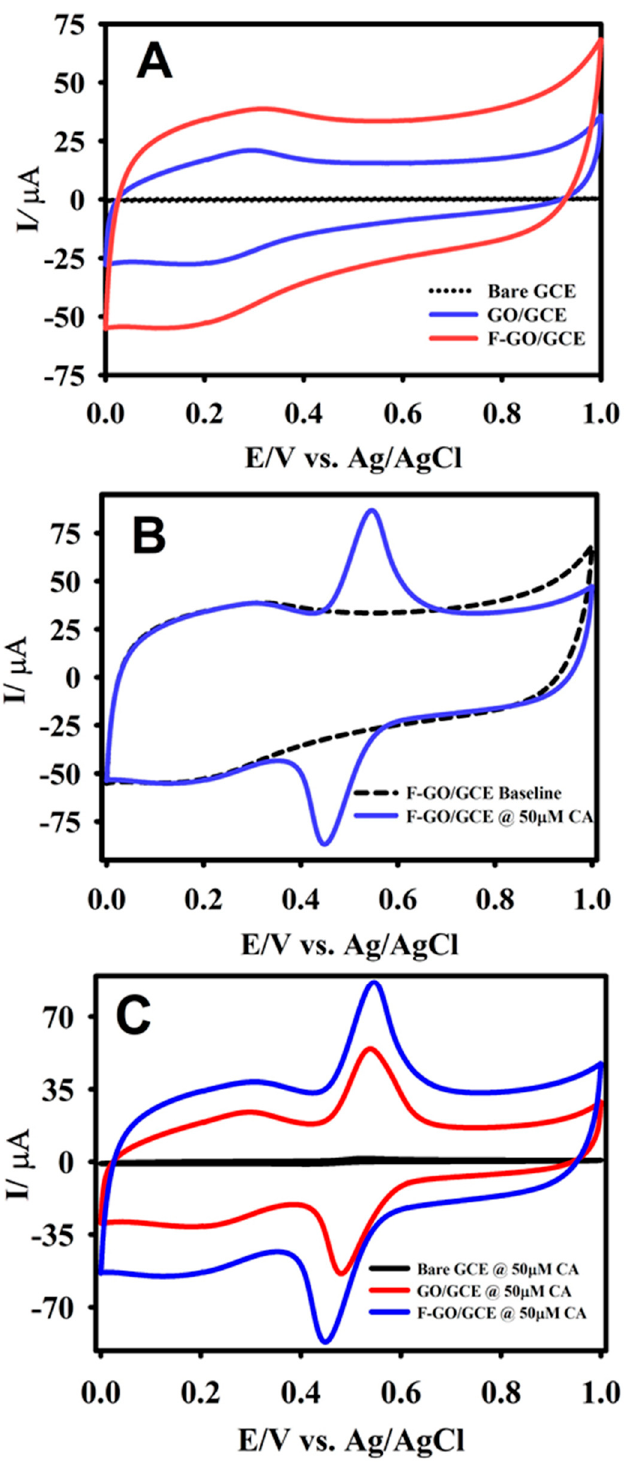
Figure 4. The CV curves of bare GCE (dashed black line), GO/GCE (blue line), and F-GO/GCE (red line) recorded in the absence of caffeic acid (CA) ( A ); the F-GO/GCE response in the presence of 50.0 µ M CA ( B ); a comparison of the modified GCEs in the presence of 50.0 µ M CA ( C ) in a 0.1 M B-R buffer solution (pH 2.65) at a scan rate of 50 mV s − 1 .